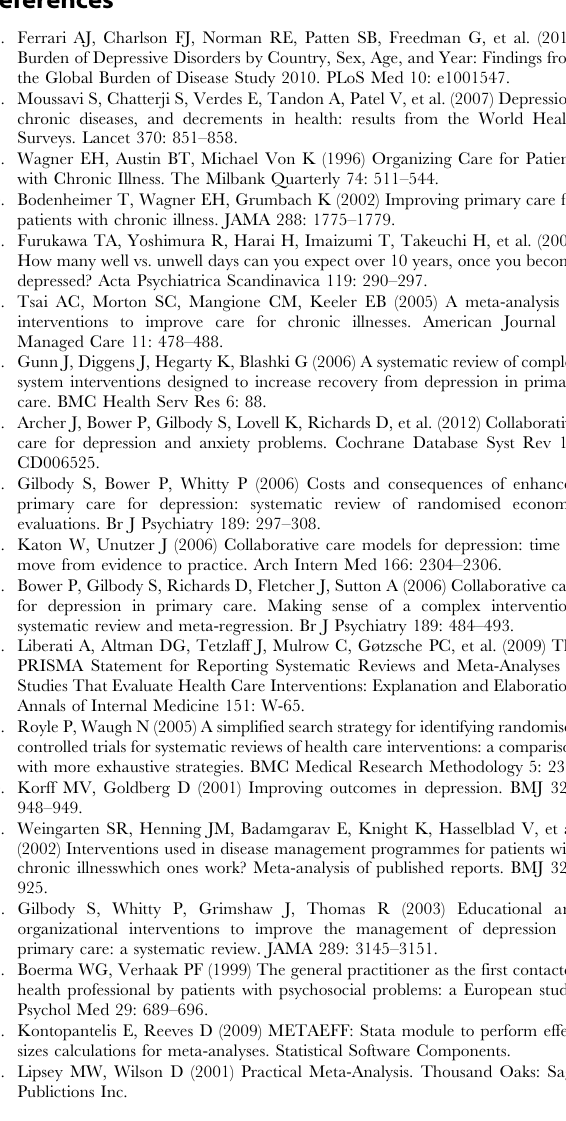
Figure S2 Forest plot of effect of collaborative care on antidepressant use. Meta-analysis of individual trial and pooled effects. Random effects model used. 95% CI=95% confidence intervals . Table S1 Characteristics of included studies. Methods S1 Central Search